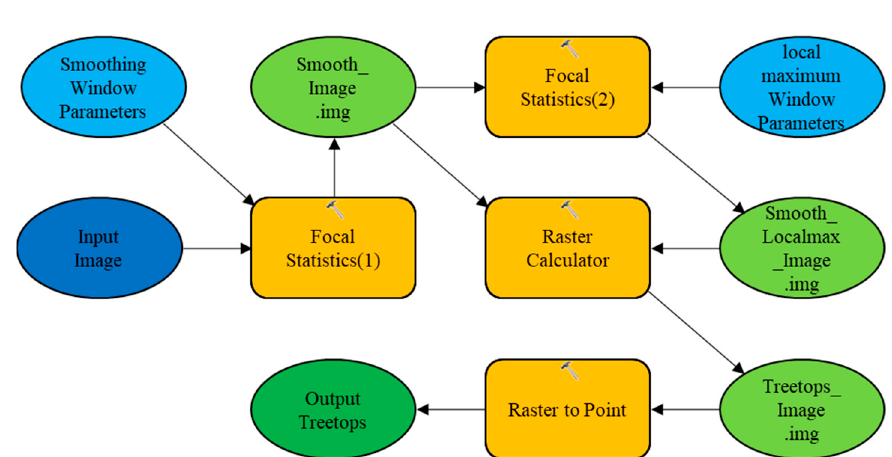
Figure A1. The LM algorithm workflow for individual tree detection using ModelBuilder. The input file is shown in dark blue color; the input parameters are shown in light blue color; the ArcGIS tools are shown in yellow color; the intermediate data is shown in light green color; and the output result is shown in dark green color.